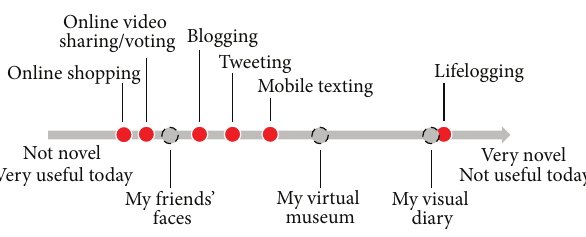
Figure 4: Novelty spectrum with example novel